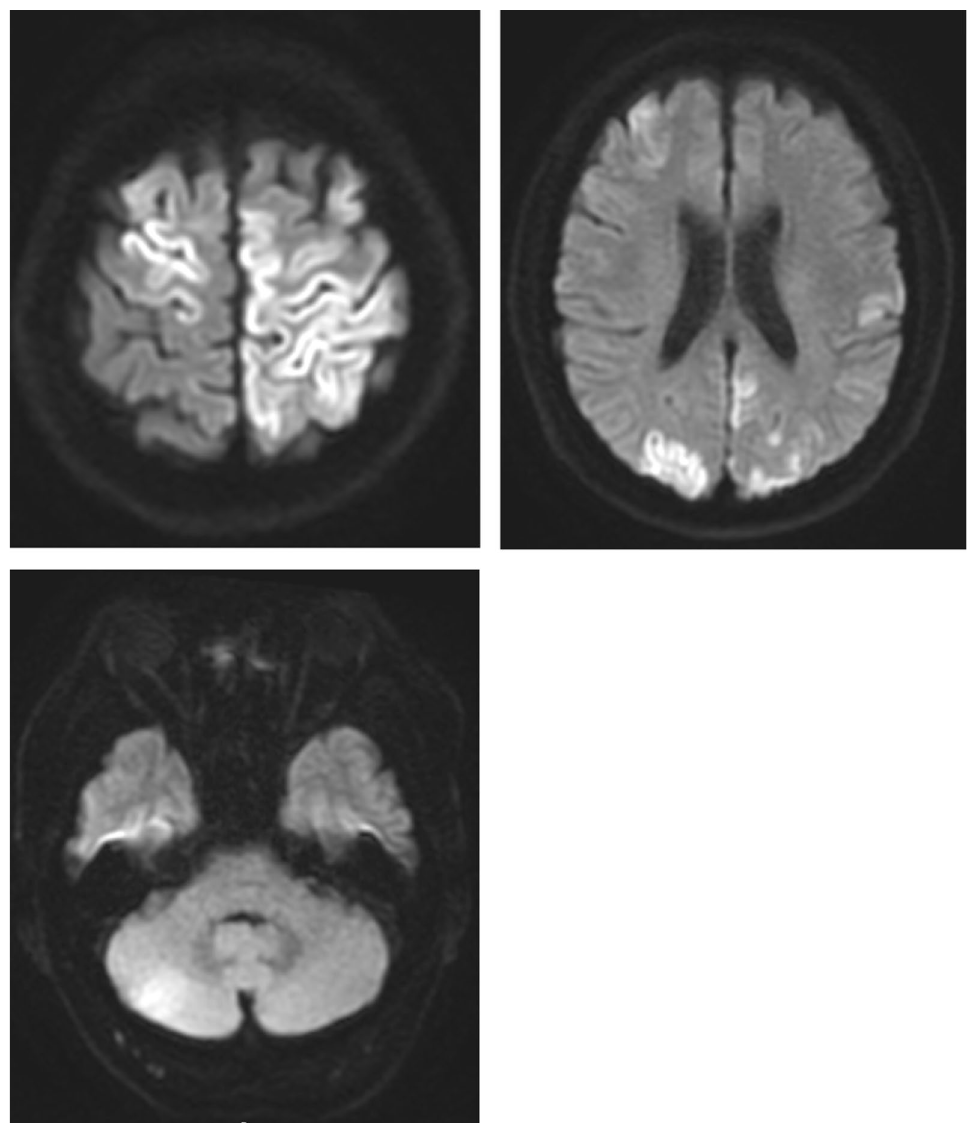
Fig. 6 Postoperative T2-weighted magnetic resonance imaging of the brain. The yellow arrow indicates a high-density presence in the broad area of the left cerebral